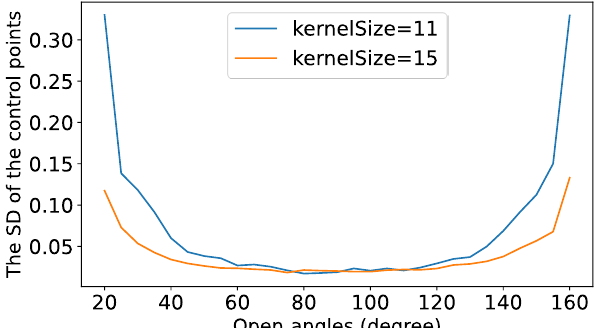
Figure 5. An illustration of the change in the standard deviations of the detected control points with respect to the open angles of the control points at two different kernel sizes.